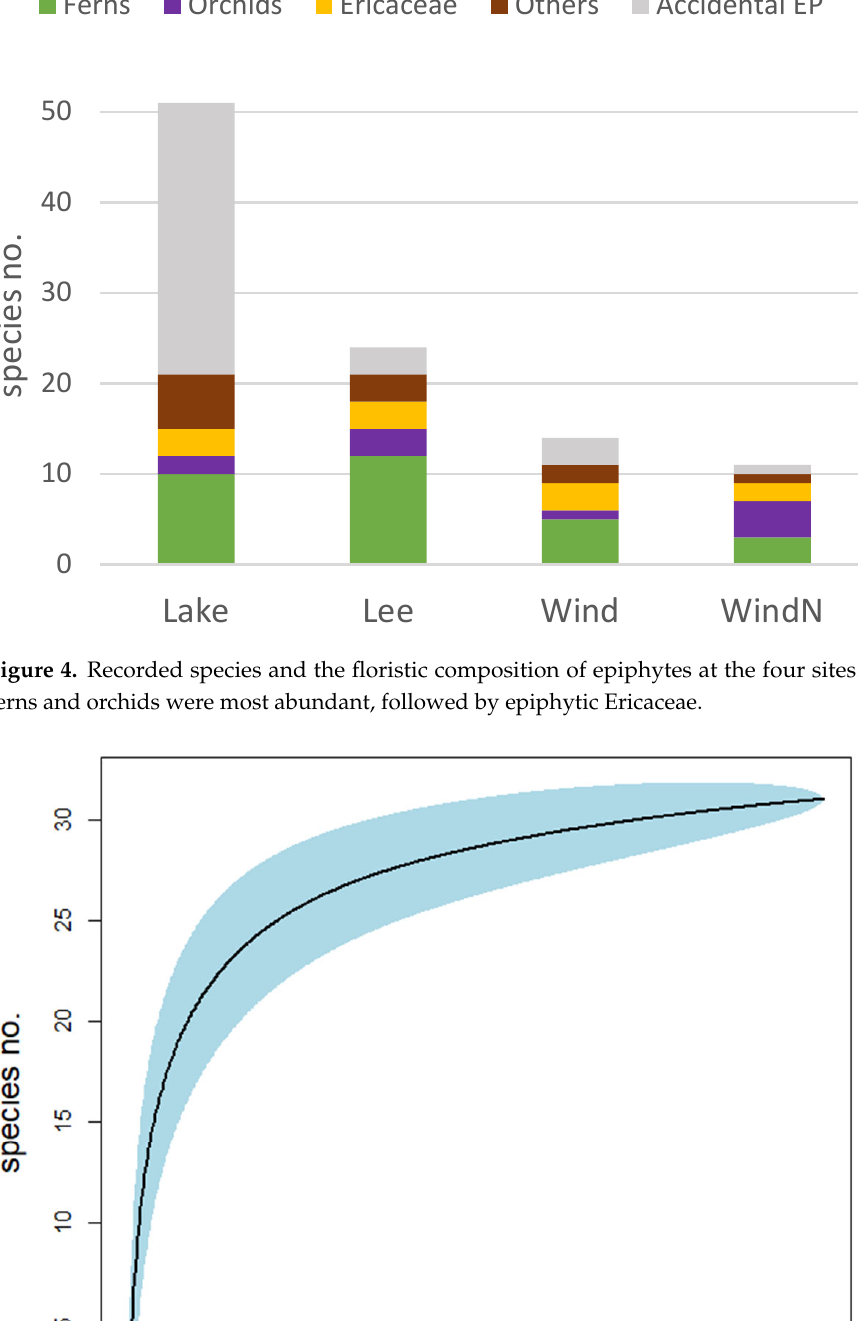
Figure 4. Recorded species and the floristic composition of epiphytes at the four sites. Epiphytic ferns and orchids were most abundant, followed by epiphytic Ericaceae. Table 3. Epiphyte abundance within crown locations at the four sites.